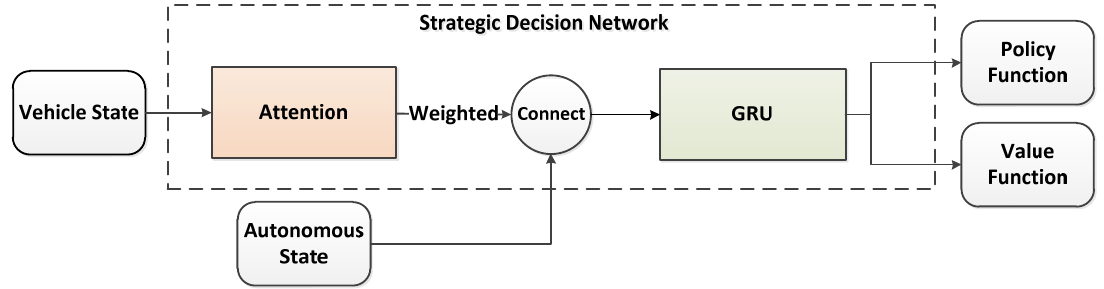
Figure 6. Strategy decision-making module.